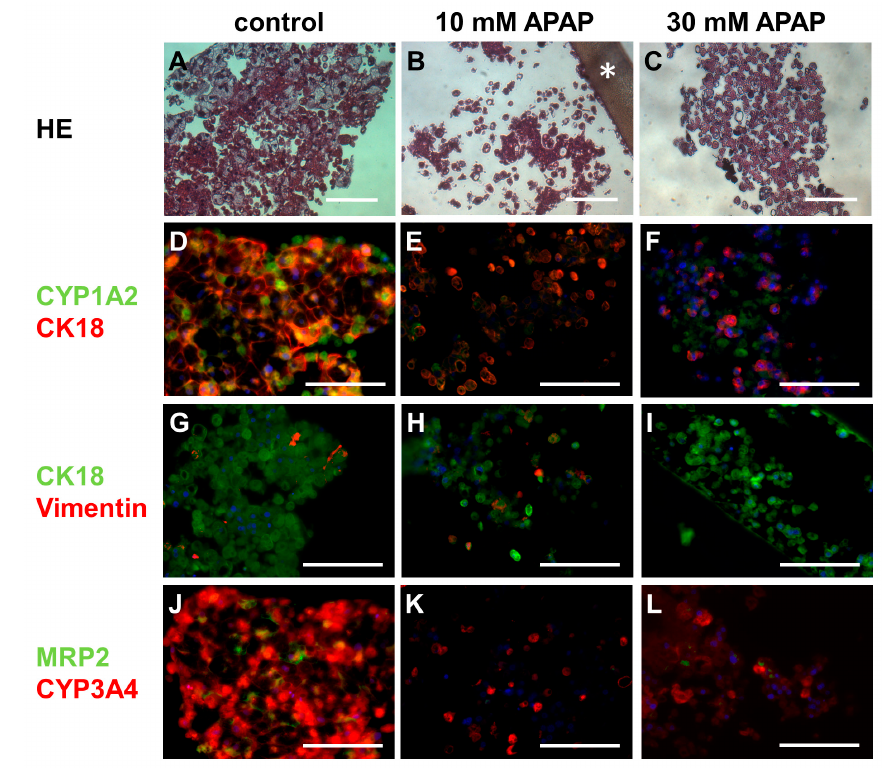
Figure 6. Histological and immunohistochemical staining of primary human liver cells after culture in untreated bioreactors (control) or those treated with 10 mM or 30 mM acetaminophen (APAP).